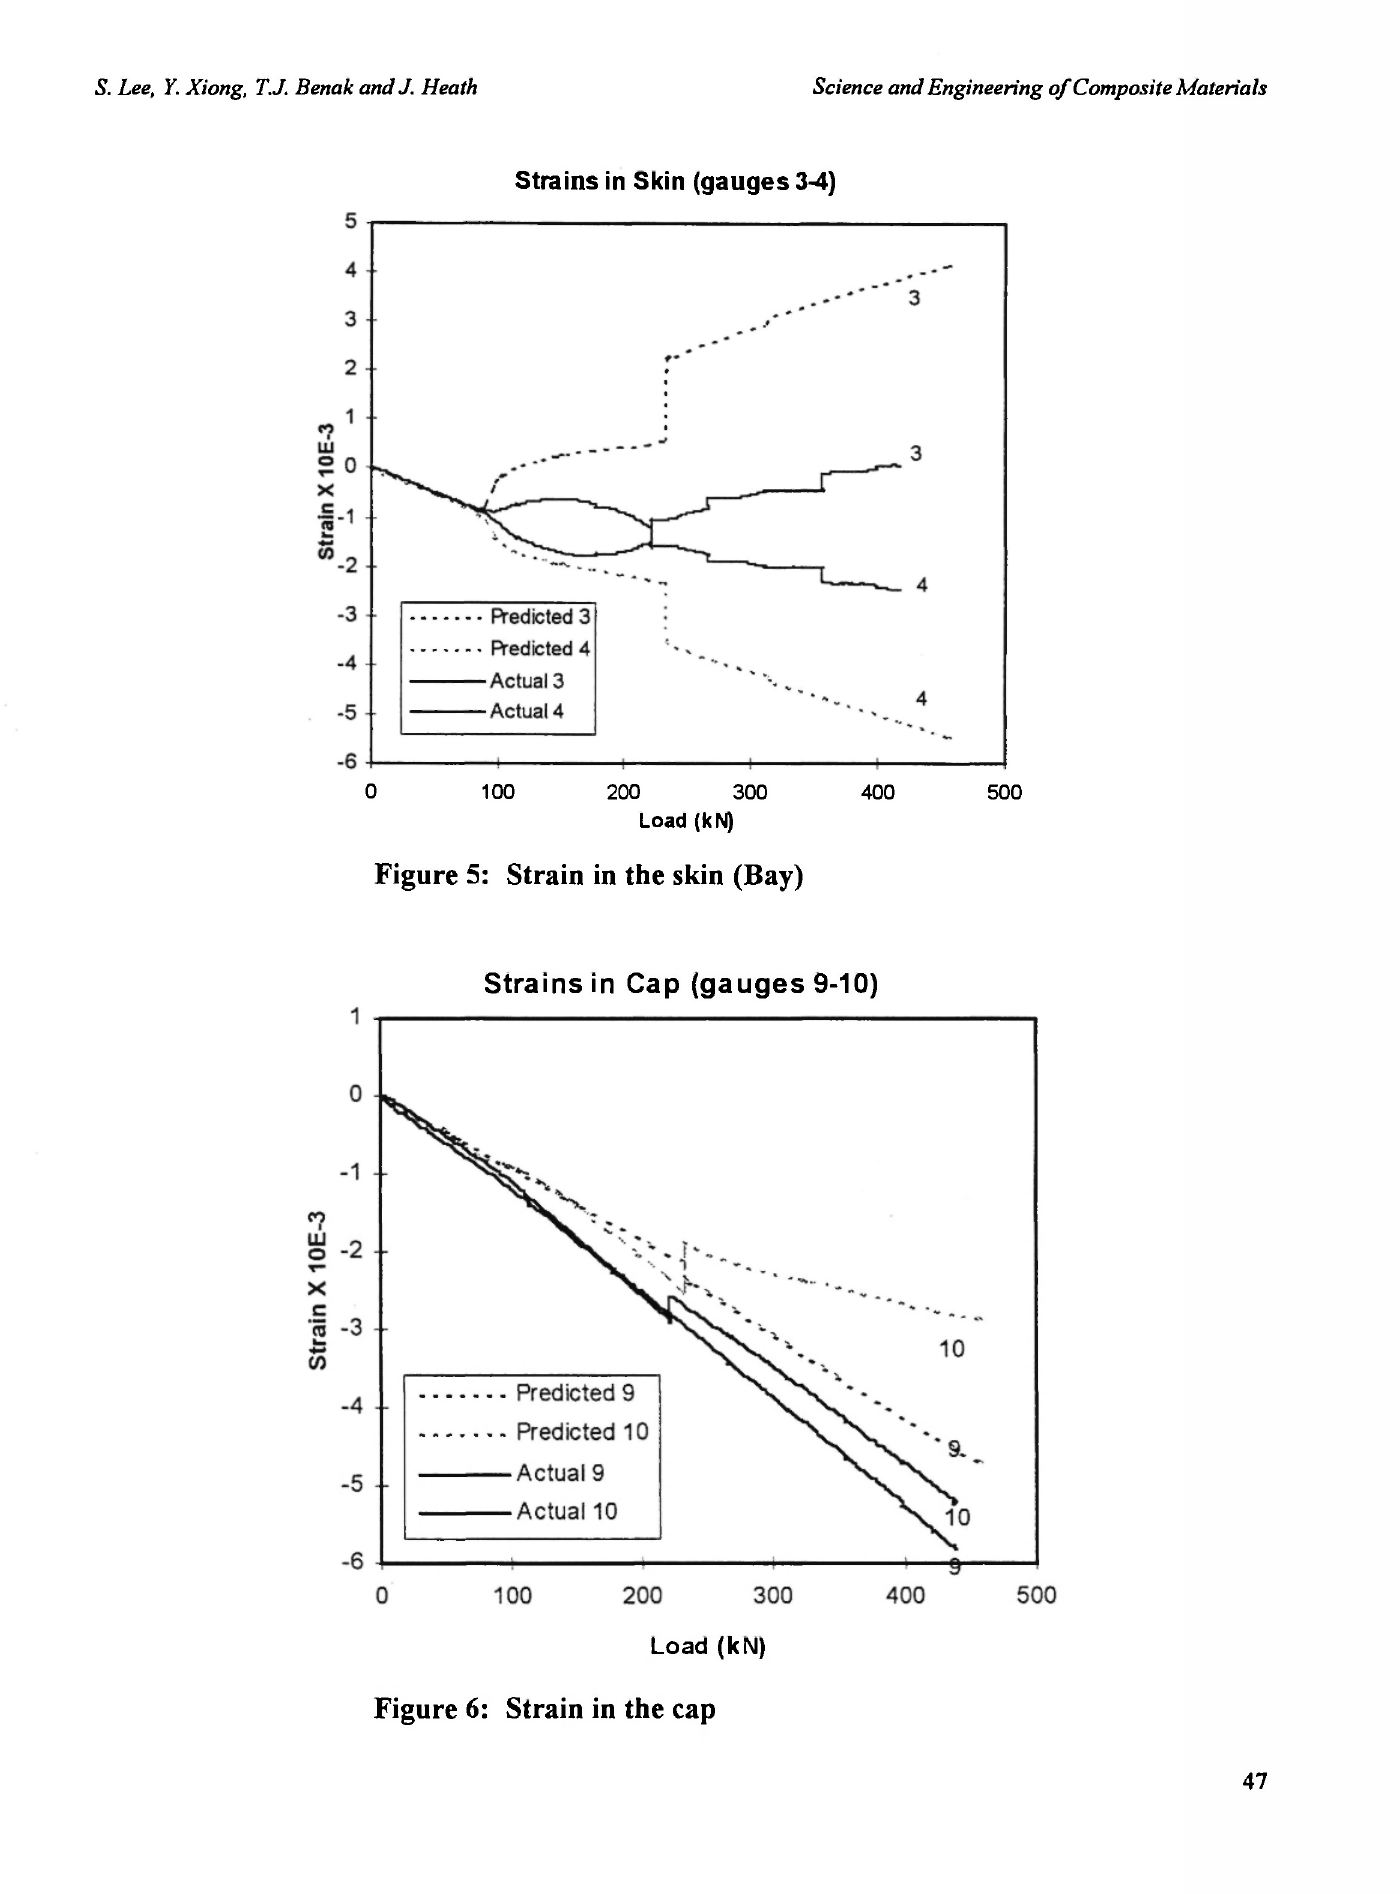
Figure 6: Strain in the